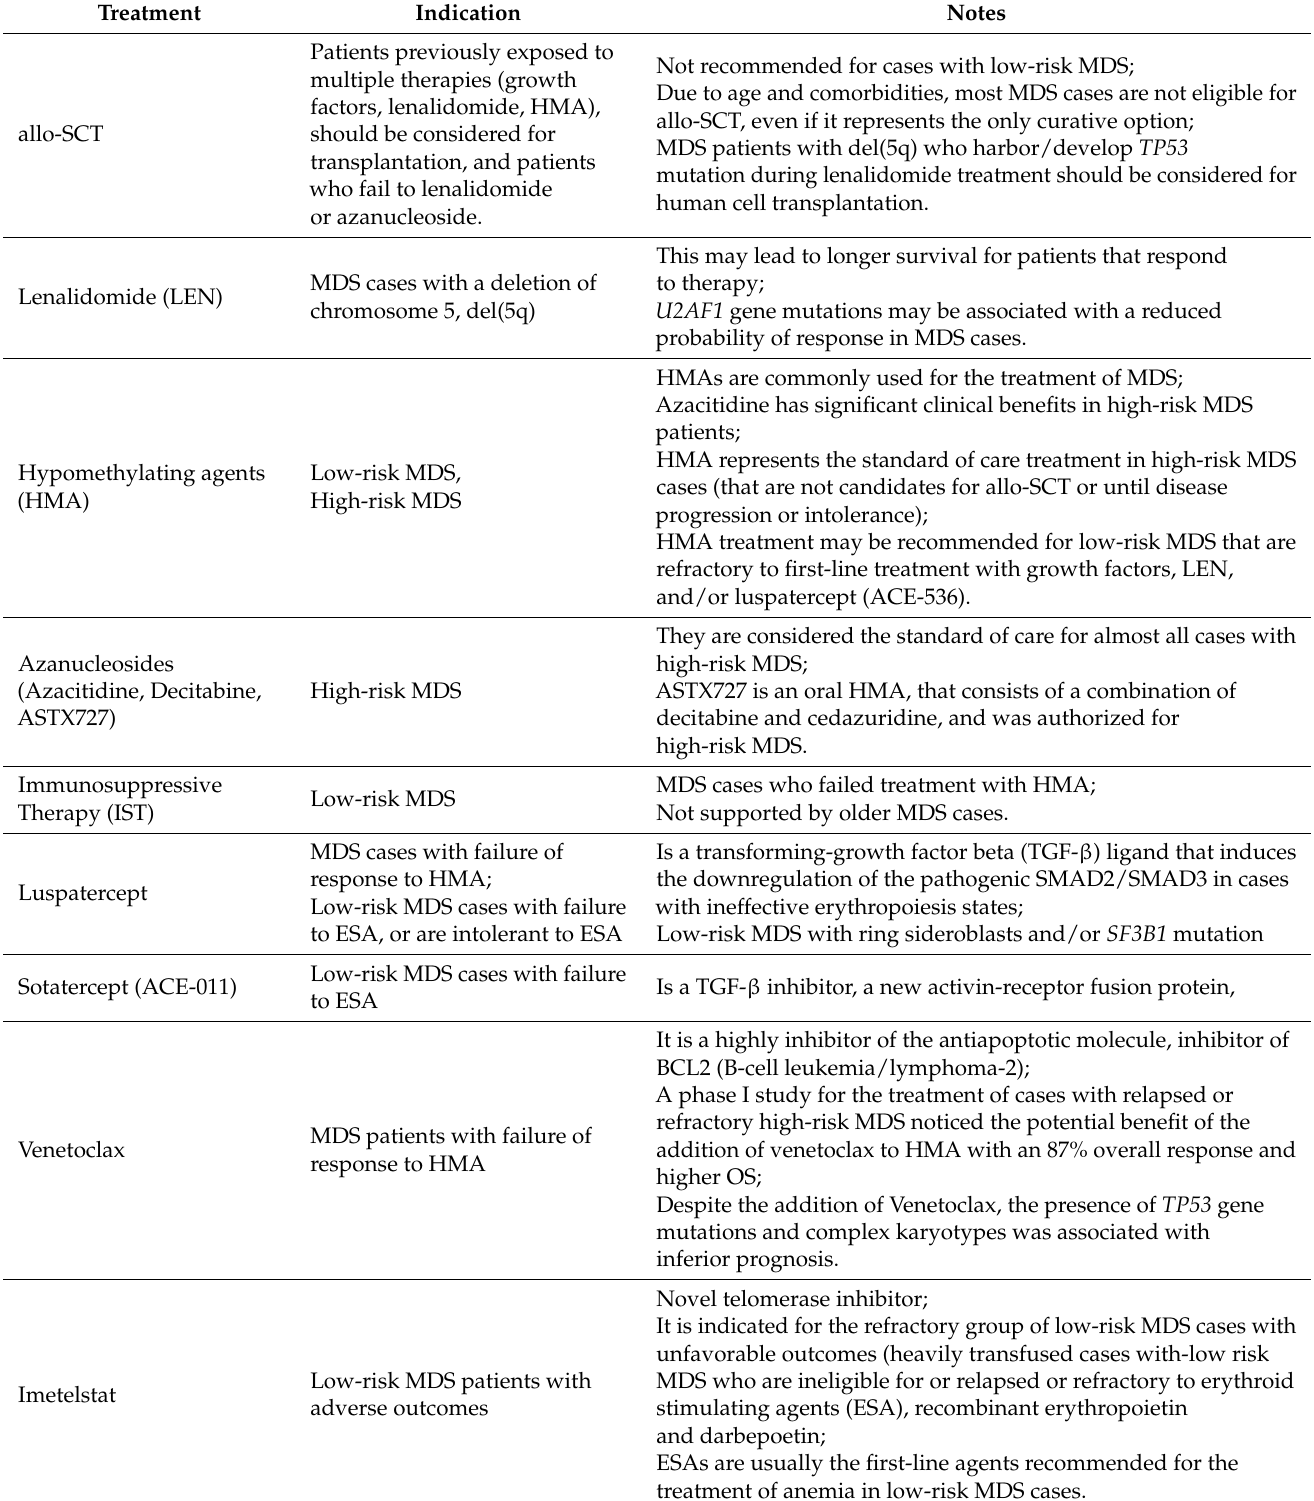
Table 3. Selected therapies for MDS